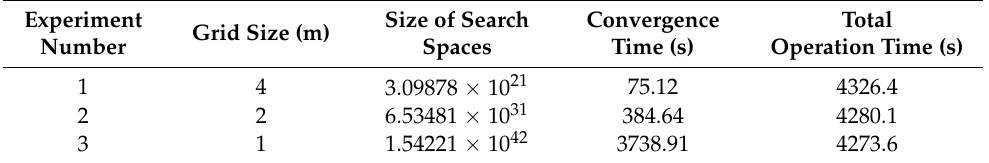
Table 2. Computational speed